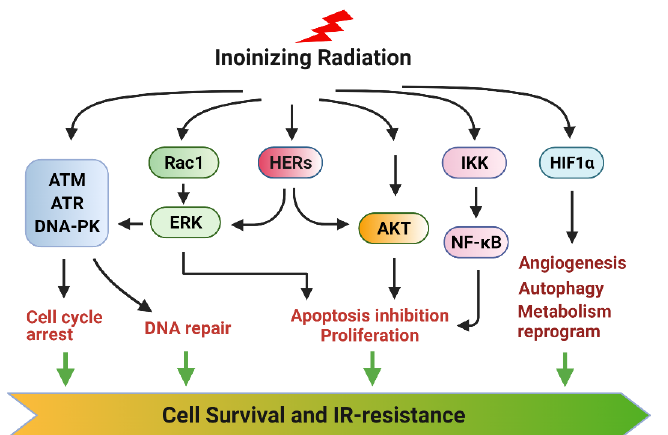
Figure 8. Overview of ionizing radiation-induced signaling pathways that promote tumor cell survival and radiation resistance. Activation of ATM, ATR, and DNA-PK signalings by radiation leads to cell cycle arrest and DNA repair. Activation of HER, ERK1/2, and AKT signaling pathways by radiation inhibits apoptosis induction and promotes cell cycle checkpoint response and DNA repair. Antioxidants produced by glycolysis reduce ROS levels in tumor cells to sustain HIF-1 α activity that promotes radioprotective mechanisms.